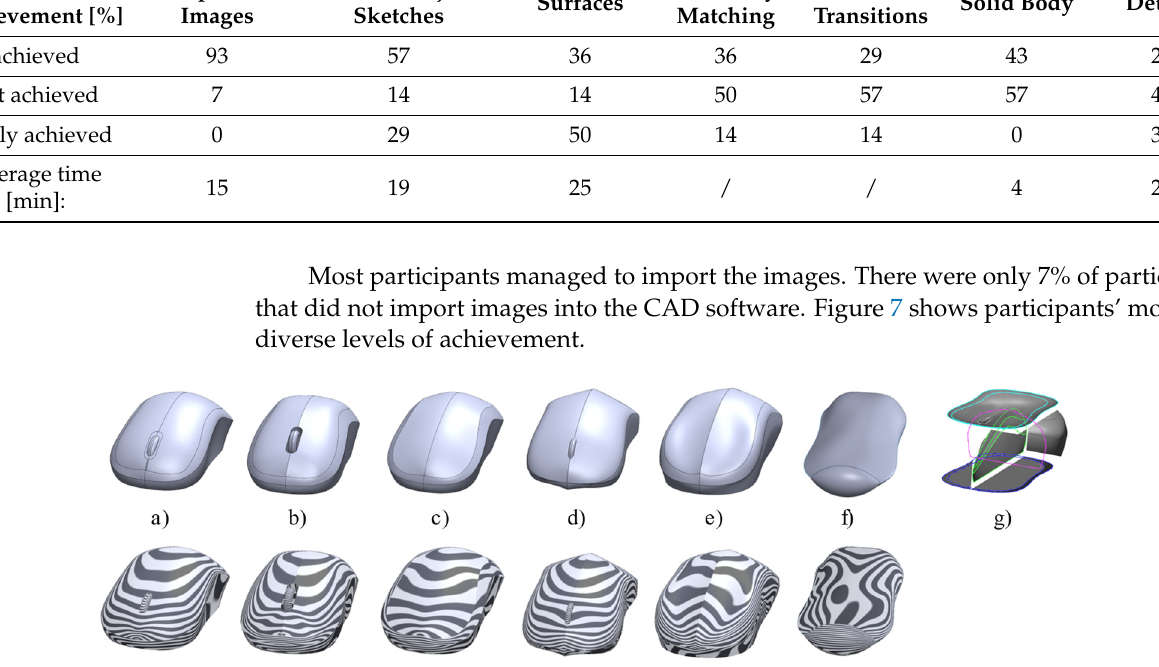
Figure 7. Crated models. ( a ) reference mouse ( b ) good shape and details, unsatisfactory surf. transitions ( c ) good shape and surf. transitions, no details ( d ) no solid body, bad surf. transitions, bad shape ( e ) bad surf. transitions ( f ) bad shape, only surfaces ( g ) didn’t reach surface phase.